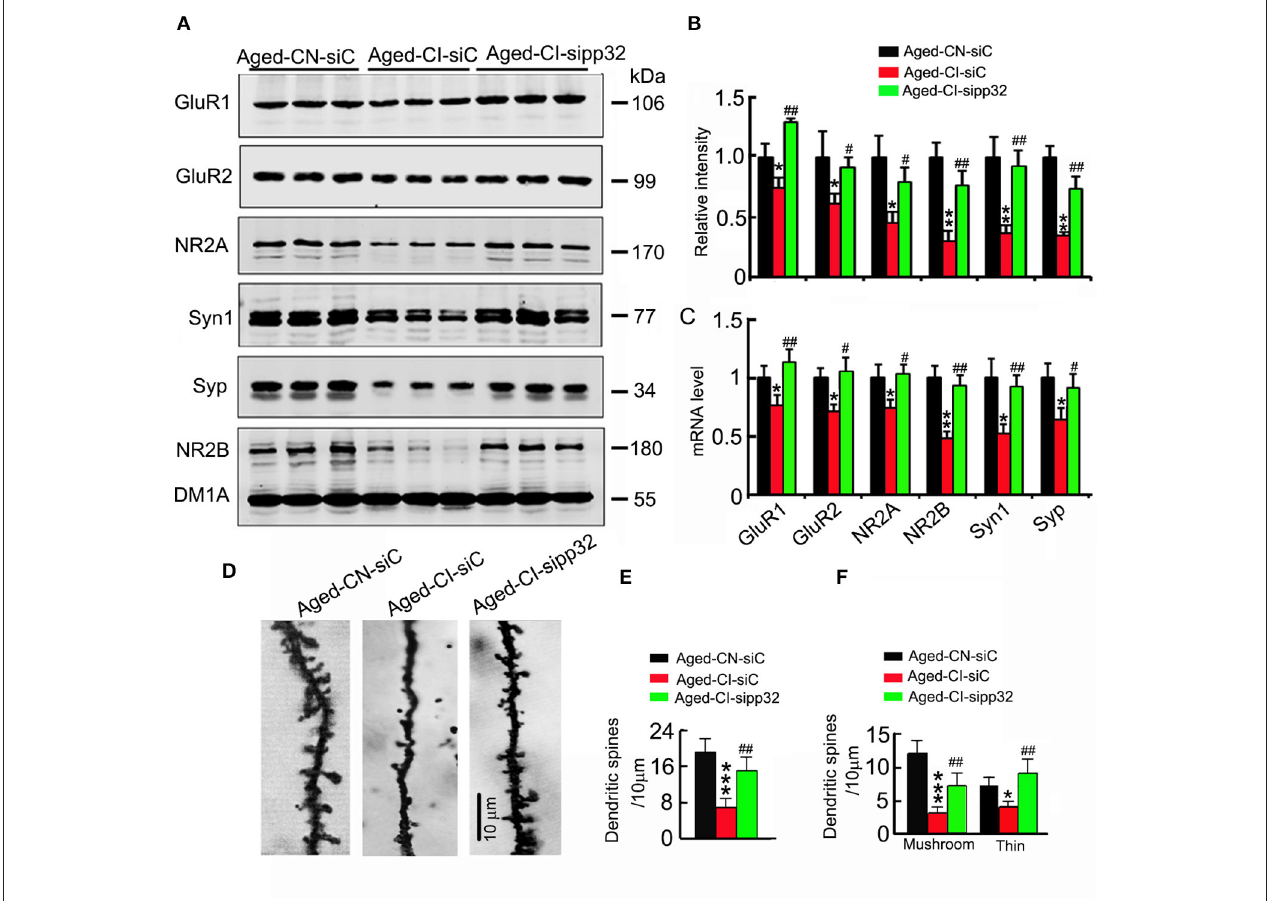
FIGURE 4 | Sipp32 reverses the impaired spine density and increases the synaptic-related proteins. (A,B). The levels of synaptic proteins in the hippocampal CA3 region of Aged-CN-siC, Aged-CI-siC and Aged-CI-sipp32 animals were detected by Western blotting and quantitative analysis ( n = 3 for each group). (C) The mRNA levels of synaptic proteins in the hippocampal CA3 region of Aged-CN-siC, Aged-CI-siC and Aged-CI-sipp32 animals were detected by qRT-PCR ( n = 3 for each group). (D,F) The representative photomicrographs of spines (D) and quantitative analysis of spine density (E) or density of mushroom- or thin-shaped spines (F) in the hippocampal CA3 neurons of Aged-CN-siC, Aged-CI-siC and Aged-CI-sipp32 animals (at least 20 neurons from five to six mice per group). * p < 0.05, ** p < 0.01, *** p < 0.001 vs. Aged-CN-siC; # p < 0.05; ## p < 0.01 vs. Aged-CI-siC (mean ± SD